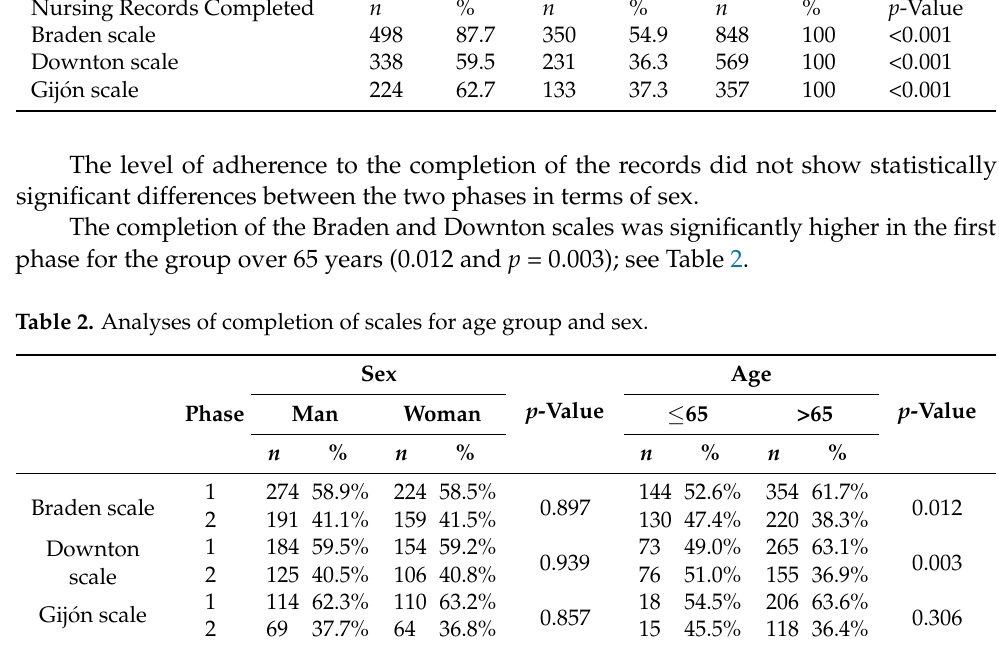
Table 1. The degree of completion of the Braden, Downton, and Gij ó n scales recorded between study phases 1 and 2. Study Periods Phase 1 Phase 2 Total Number of Patients Assessed n = 568 n = 637 n = 1205 Nursing Records Completed n % n % n % p -Value Braden scale